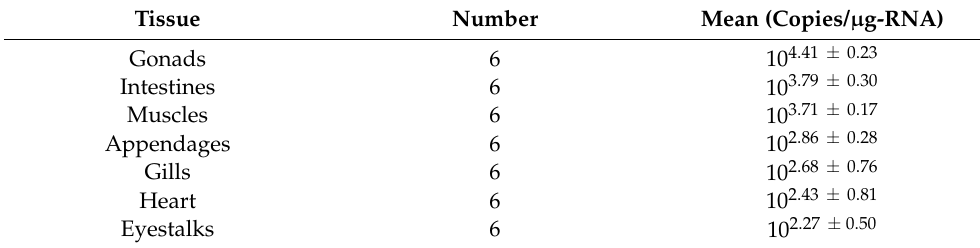
Table 3. CMNV copies in different tissues detected in CMNV-positive M. rosenbergii